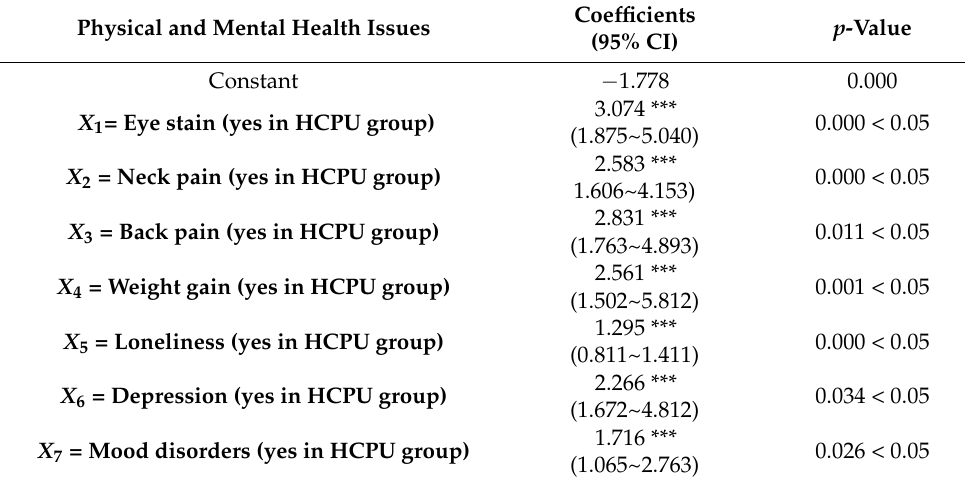
Table 3. Odds of negative impact on personality under different physical and mental health